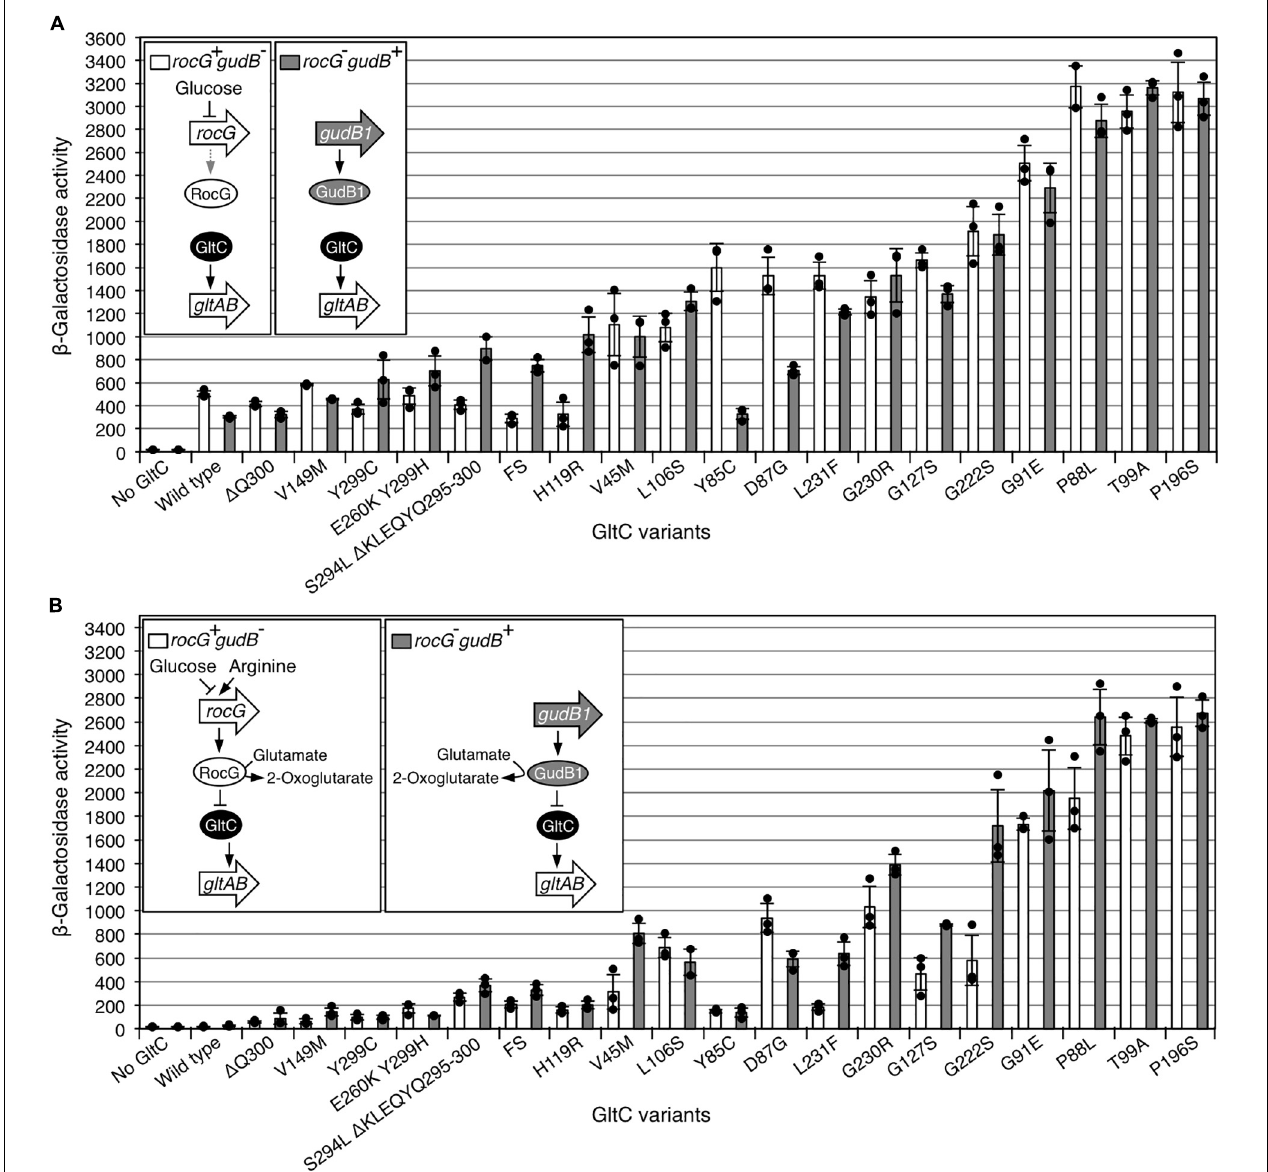
FIGURE 4 | Regulation of the P gltA promoter by the GltC variants with enhanced activator function in the strains BP881 ( P gltA -lacZ gltC − rocG + gudB − ) and BP852 ( P gltA -lacZ gltC − rocG − gudB1 ) synthesizing RocG and GudB1, respectively, and carrying a translational P gltA -lacZ fusion during growth in CSE-Glc minimal medium without (A) and with arginine (B) . Arginine was added to a final concentration of 0.5% (w/v). Data points represent biologically independent replicates. Bars indicate means of replicates and the standard deviations are shown. β -Galactosidase activities are given as units per milligram of protein. The plasmids carrying the gltC alleles are listed in Table 2 . FS, frame shift GltC mutant (SLSWSSINNDCRHASFDNSLA293-313).